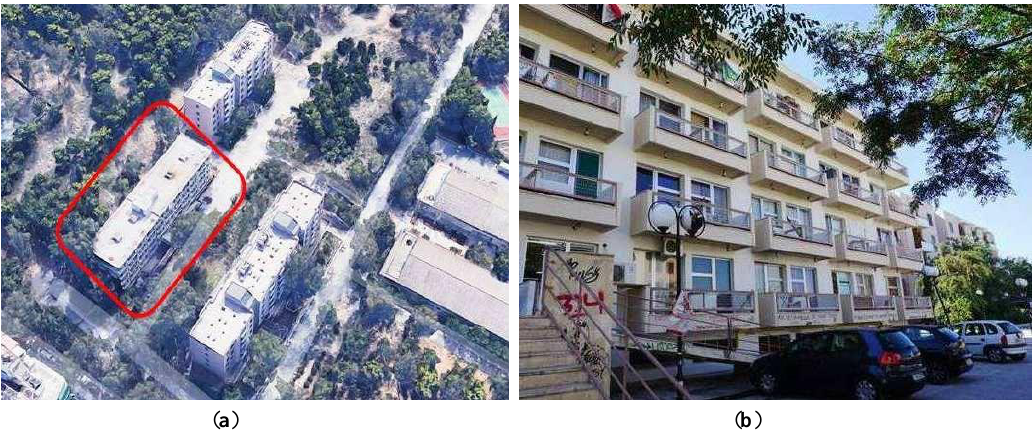
Figure 1. Arial view of the location ( a ) and ( b ) the façade of the building